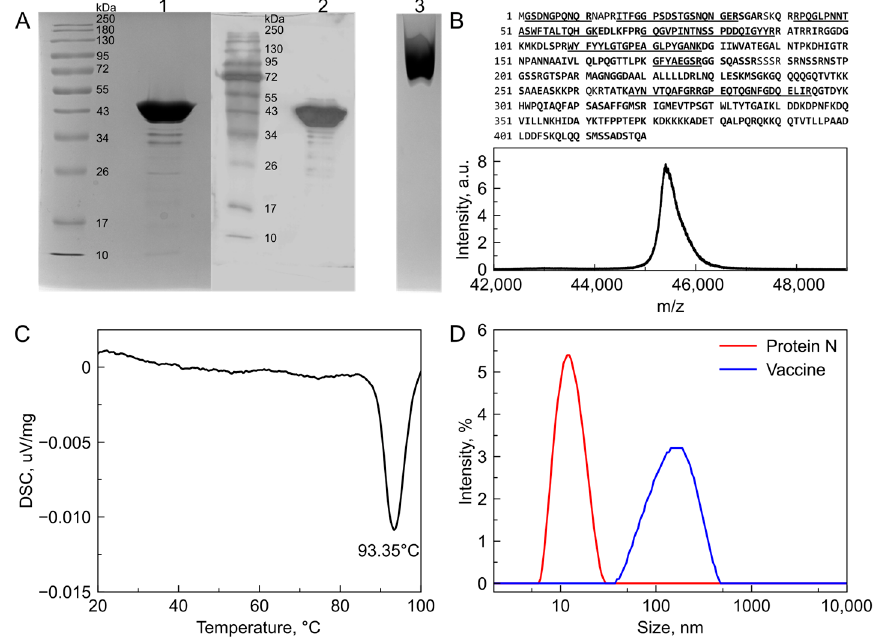
Figure 1. Biochemical characterization of recombinant SARS-CoV-2 N protein. ( A ) SDS-PAGE and Western blotting confirm the molecular weight and recognition by N-specific antibodies. Native PAGE shows homogeneous distribution of recombinant N as one species. Lanes: 1—SDS-PAGE of recombinant N protein solution; 2—Western blot of recombinant N protein solution; 3—native PAGE of recombinant N-protein solution. Uncropped photo of Western Blot membrane is presented in Figure S2. ( B ) MALDI-MS confirms the predicted molecular weight of monomeric recombinant nucleocapsid protein and 96.7% of sequence coverage was achieved. Confirmed sequence is marked in bold. Peptides subjected to MS/MS analysis are underlined. ( C ) Differential scanning calorimetry thermograms of 0.2 mg/mL N-protein samples show no endothermic peaks corresponding to protein globule melting but show a distinct exothermic peak at 93 °C corresponding to oligomer particles melting. ( D ) Nucleocapsid protein forms oligomeric structures with a hydrodynamic diameter of approximately 13 nm (red line) which corresponds to a M w of approximately 200 kDa suggesting the formation of a tetramer. The emulsion formed by squalane, (D,L)- α -tocopherol and polysorbate 80 exposes the protein on oil in water drops with a size of approximately 150 nm in diameter (blue line).